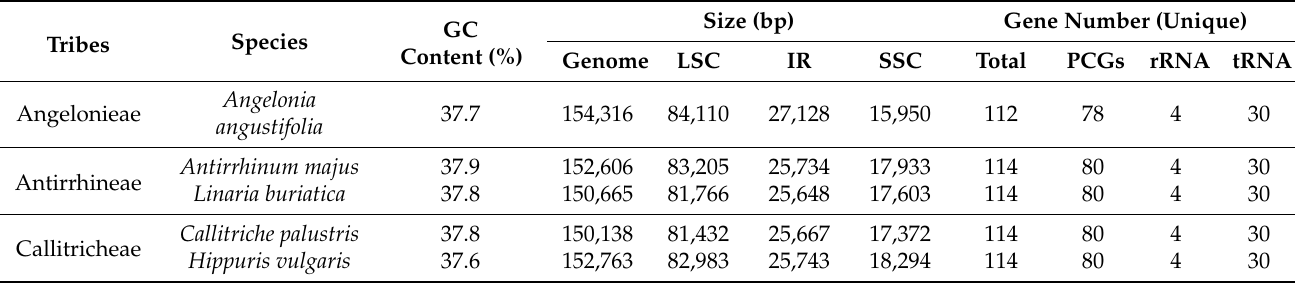
Table 1. Comparison of plastome features among Plantaginaceae plants.